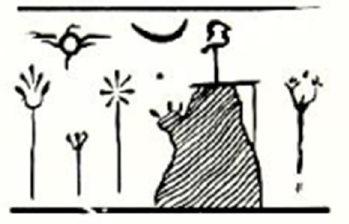
Figure 12. Iron Age seal found in the Ceremonial District of Carchemish (from Woolley and Barnett 1952, fig. 75).